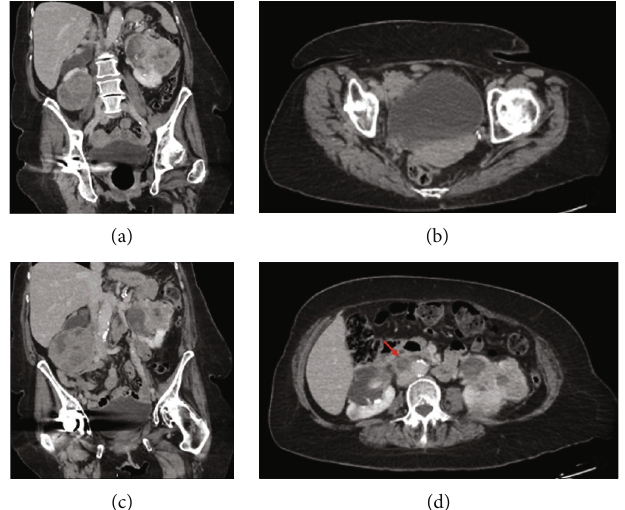
Figure 1: (a) Coronal imaging of large multilobular solid and cystic mass involving most of the left mid to upper pole with a portion of the mass wall not well delineated possibly involving the renal pelvis measuring approximately 8 : 5 × 9 : 2 × 9 : 2cm . (b) Axial view of high-density material within the posterior aspect of the urinary bladder. (c) Coronal imaging of right complex solid and cystic mass in the upper pole measuring 2 : 4 × 1 : 7 cm , large solid cystic mass at the lower pole measuring 8 : 6 × 9 : 1 × 7 : 8cm , and an ill-de fi ned cortical based mass like area in the lower pole measuring approximately 17 × 9mm . (d) Axial view of aorto-caval adenopathy with arrow pointing to periaortic adenopathy.